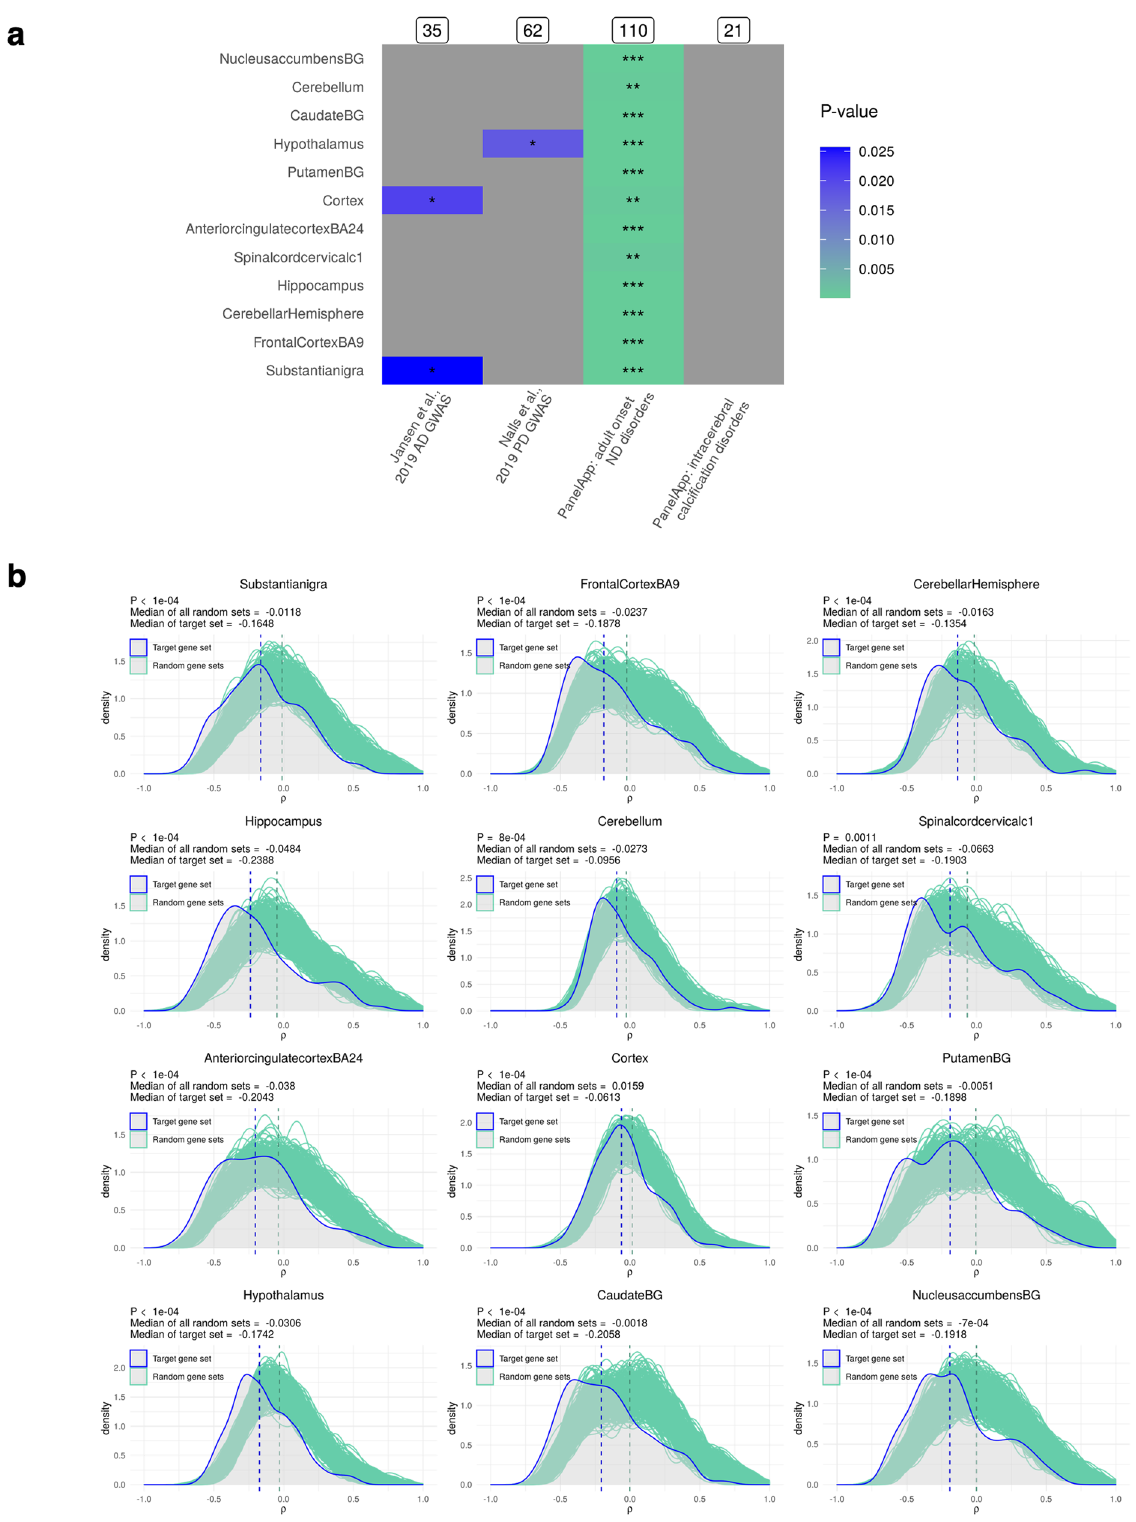
Fig. 5 Visualisation of ND gene set associations with the mitochondrial genome. a Heatmap to show P values associated with the median of four ND- related gene sets being more extreme than that of 10,000 random gene sets in 12 GTEx CNS regions. Raw P values (below P < 0.05) are represented by the colour scale, with the following asterisks overlaid to indicate which multiple test correction thresholds are passed: *0.05/12< P < 0.05; **0.05/ 12*4 < P < 0.05/12; *** P < 0.05/12*4. Grey squares indicate associations for which P > 0.05. b Visualisation of the results in part a, for the AOD target set only. The target gene set distribution is shown in blue and the distribution of 10,000 random size-matched gene sets is shown in green. Vertical dotted lines represent the medians of the target gene set (blue) and the central median of the 10,000 bootstrap sets (green). This fi gure was produced using the MitoNuclearCOEXPlorer